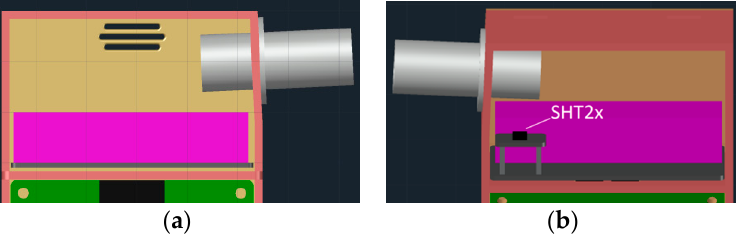
Figure 1. Drawing of the designed gas chamber as a dedicated compartment in the device housing (in salmon). View of the mouthpiece (in light gray) and ventilation grate (in beige) ( a ). The SHT21 is soldered to a raised daughter board (in dark gray) allowing for indirect airflow as well as thermal separation from the gas sensor array (in violet) printed circuit boards (PCB) ( b ).